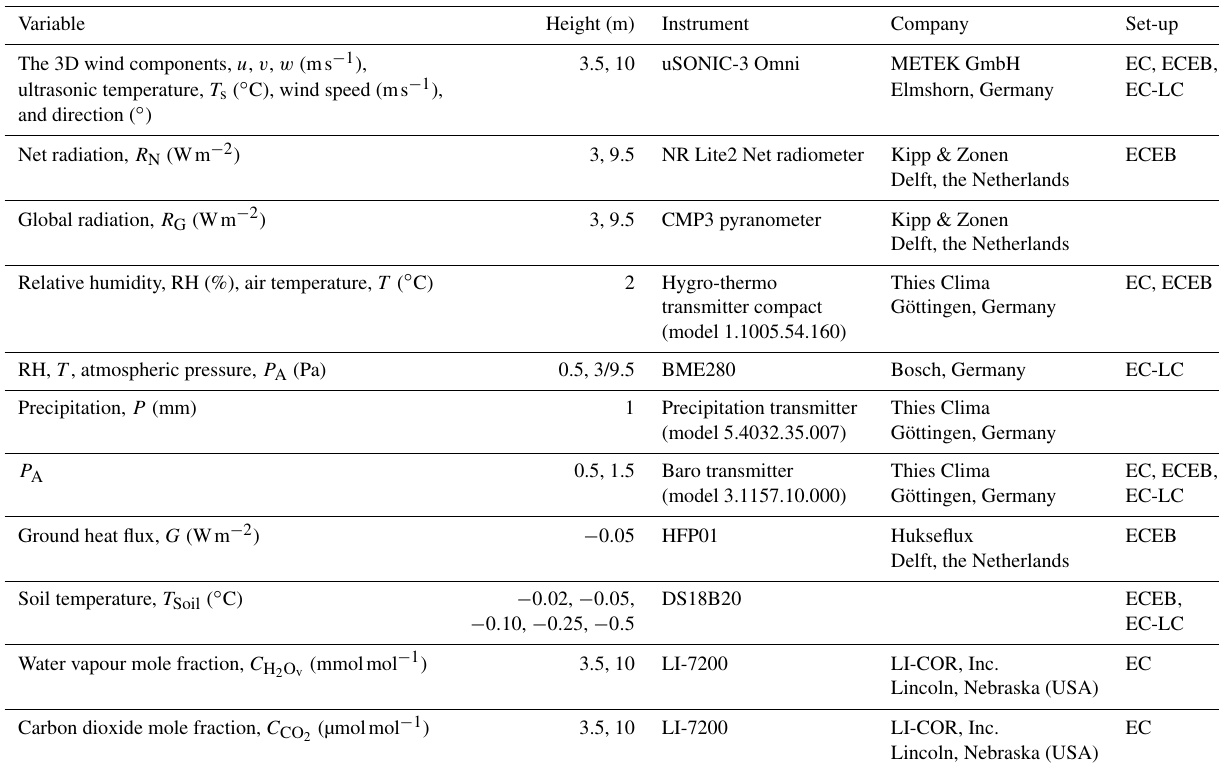
Table 2. Instrumentation for flux and meteorological measurements used at all five AF and MC systems. Set-up corresponds to eddy covari- ance (EC), low-cost eddy covariance (EC-LC), and eddy covariance energy balance (ECEB). Variable Height (m) Instrument Company